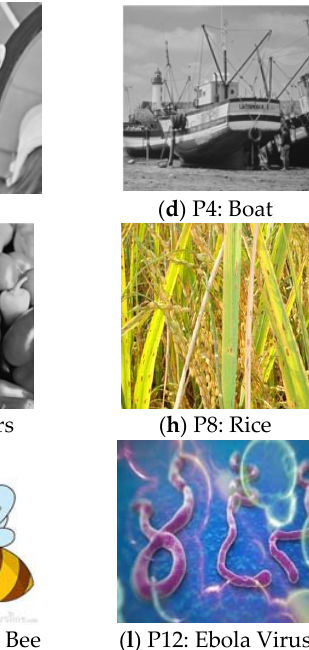
Figure 6. Effect of threshold in skipping blocks. Again, DE schemes reduce the scope of embedding by making pixel groups and allowing the embedding procedure to embed only one bit per group. Although the LSB replacement ‐ based scheme supports modification of multiple LSBs, in our experiment, we restricted that scheme to modify only a single LSB for the sake of comparison with our scheme. Besides, replacement of multiple bits will obviously destroy the image quality, noticeably. On the contrary, the proposed scheme allows all the pixels to conceive message bits. In the proposed scheme, the errors are shifted to the right by 1 when “1”s are embedded into the error 1, and to the left by 1 when “1”s are implanted into − 1. That strategy has led our scheme to present dominating results in terms of capacity over the others by obliging all pixels equally to accept message bits. Figure 7 demonstrates some of the results. The embedding capacity of DE, APPM, Euclidean, LSB replacement, and proposed scheme are depicted as groups for each image. Our proposed scheme and the LSB replacement scheme achieve the capacity of 1 bit per